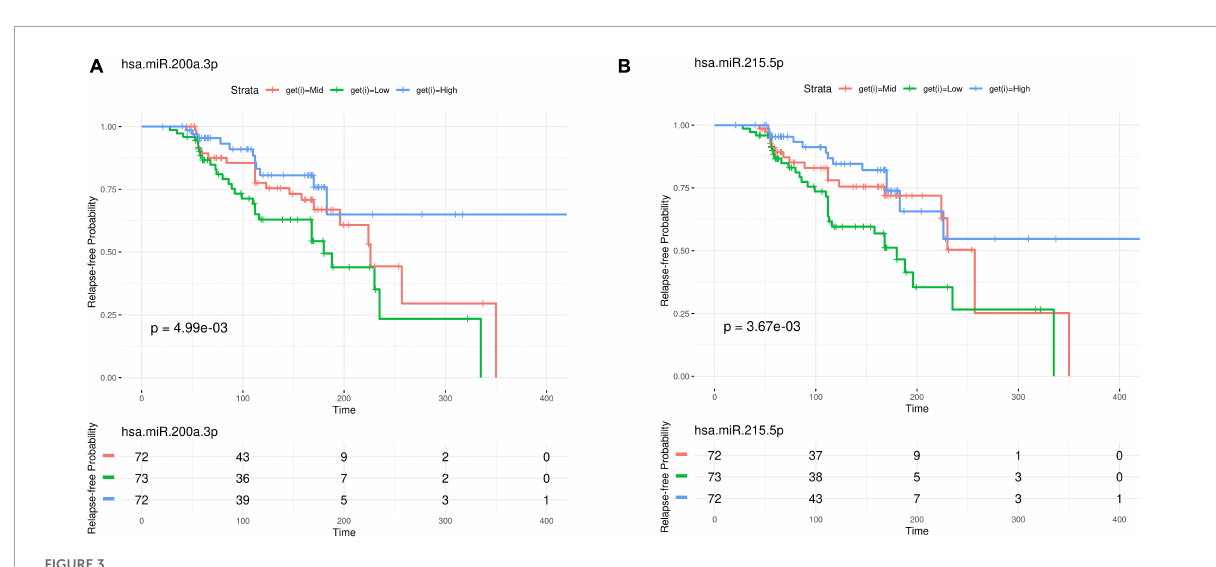
FIGURE3 Kaplan–Meier curves for (A) hsa-miR-200a-3p , (B) hsa-miR-215-5p